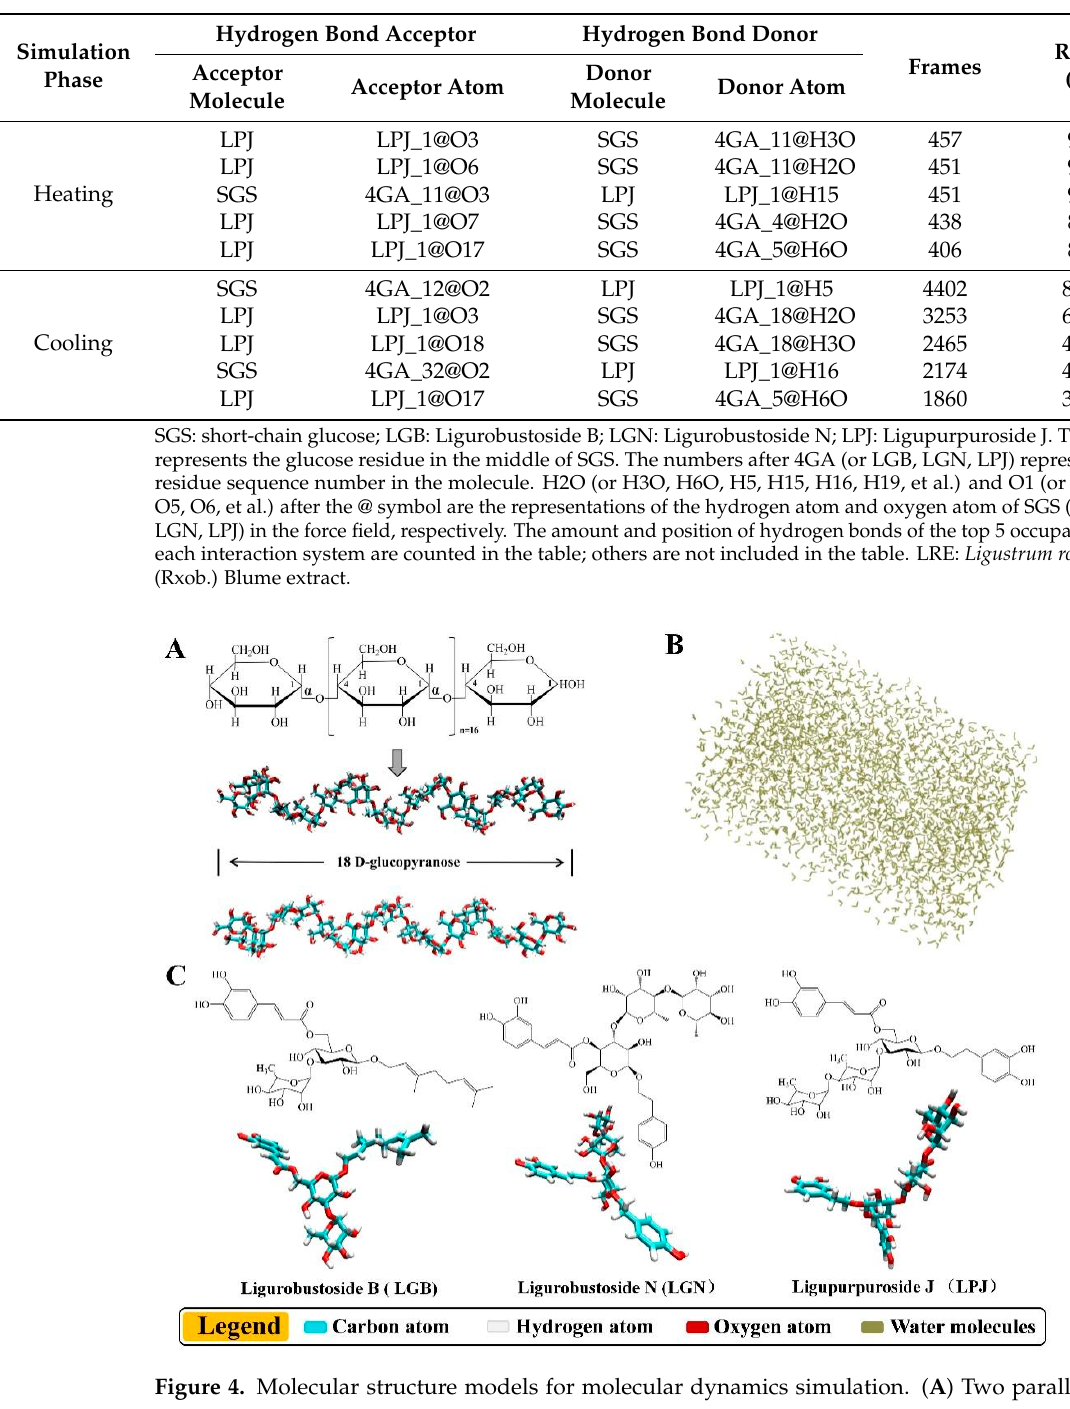
Figure 4. Molecular structure models for molecular dynamics simulation. ( A ) Two parallel SGS (short-chain glucose) chains, ( B ) TIP3PBOX water solvent box, ( C ) phenolic compounds identified from LRE: Ligurobustoside B (LGB), Ligurobustoside N (LGN) and Ligupurpuroside J (LPJ). LRE: Ligustrum robustum (Rxob.) Blume Table 3. The intramolecular hydrogen bonds within two SGS chains in different interaction systems.